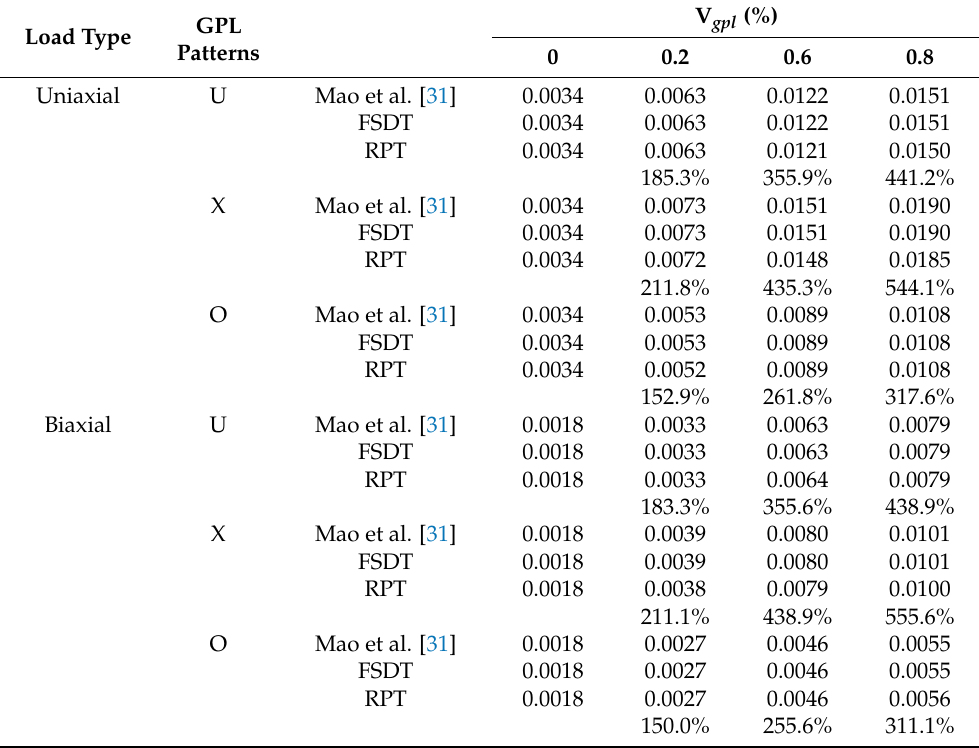
Table 4. Dimensionless critical bucking load of an SSSS FG-GRP plate with different graphene volume fractions and different distribution patterns under uniaxial and biaxial